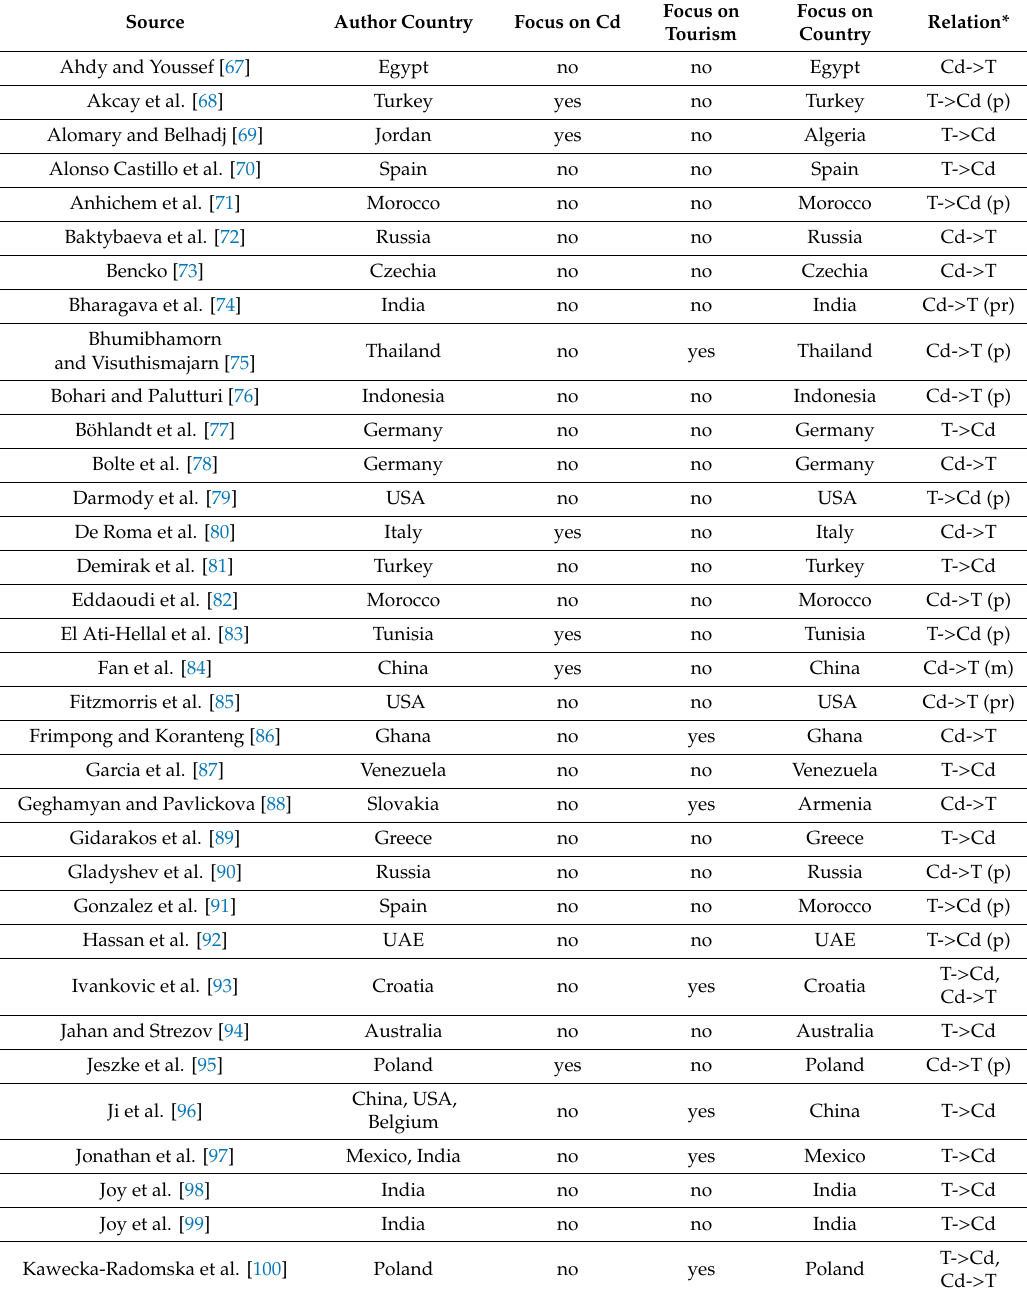
Table 1. Basic information on the studies considered in the present